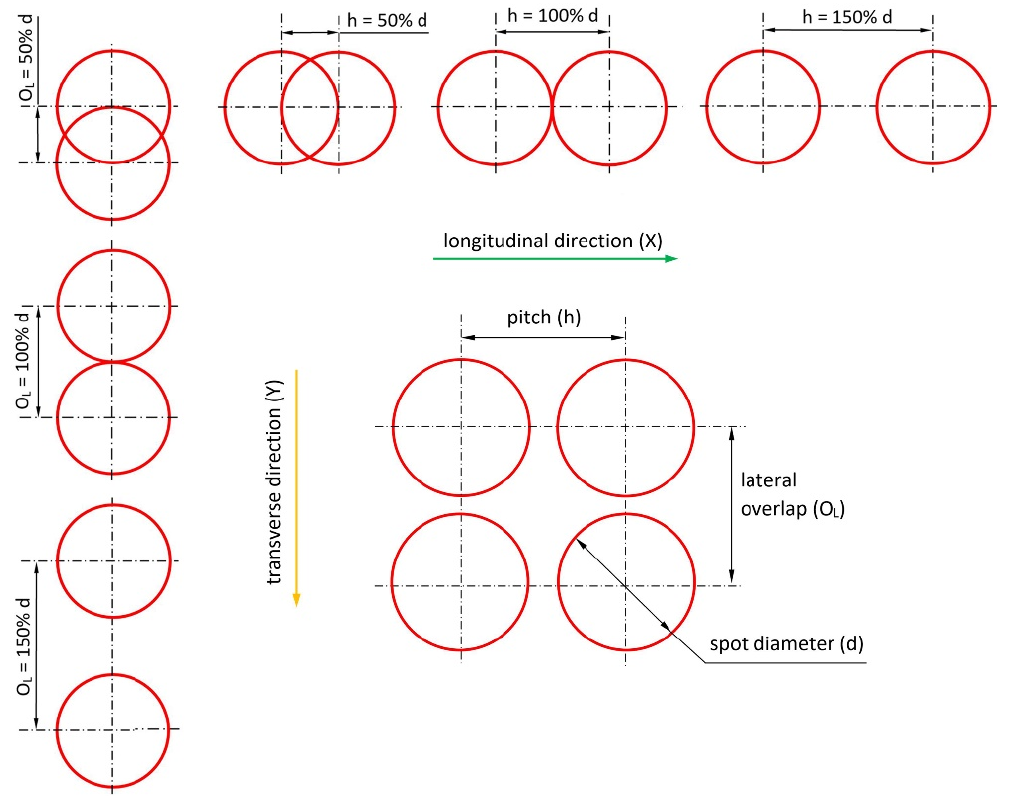
4 of 23 Table 1. Main characteristics and operating range of laser setup. Characteristic